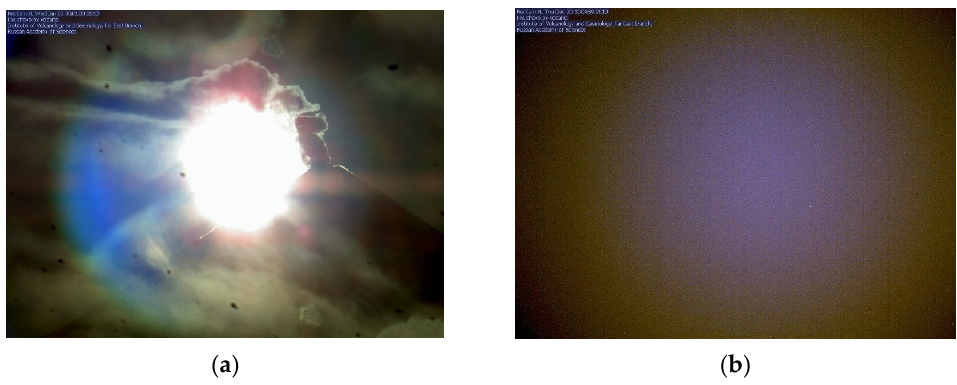
Figure 5. Examples of incorrectly clustered images: ( a ) Klyuchevskoy volcano daytime image at 03:01 3 January 2018, false labelled as night; ( b ) Klyuchevskoy volcano nighttime image at 13:05 20 December 2018, false marked as day.